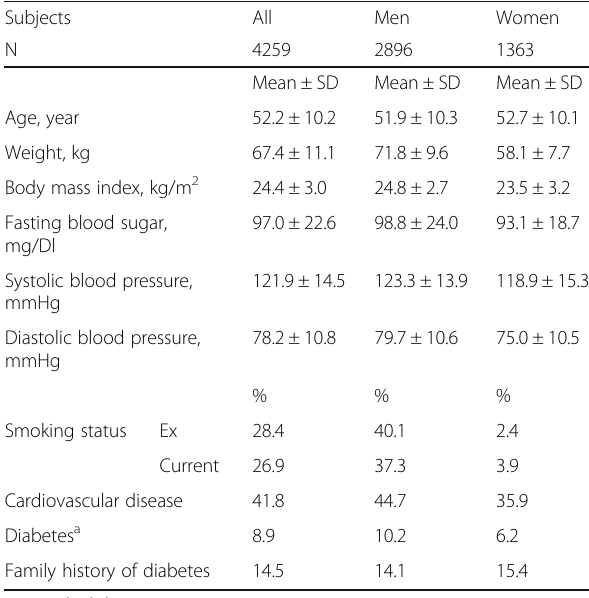
Table 1 General characteristics of the study